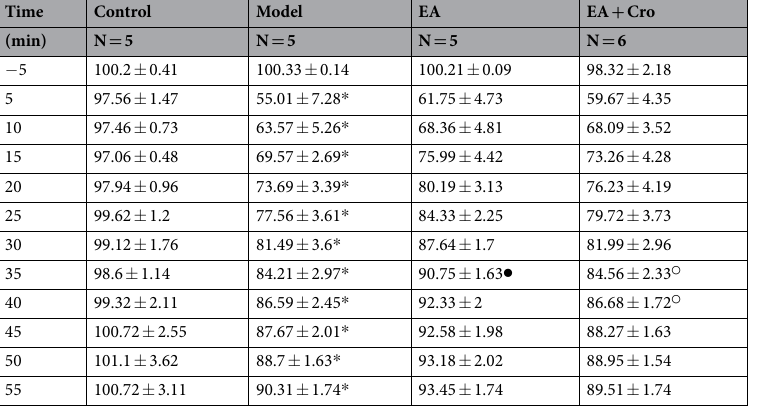
Table 1. Comparison of relative heart rates among the groups (AVG ± SEM). * P < 0.05, Control vs. Model; ● P < 0.05, Model vs. EA; ○ P < 0.05, EA + Cro vs.